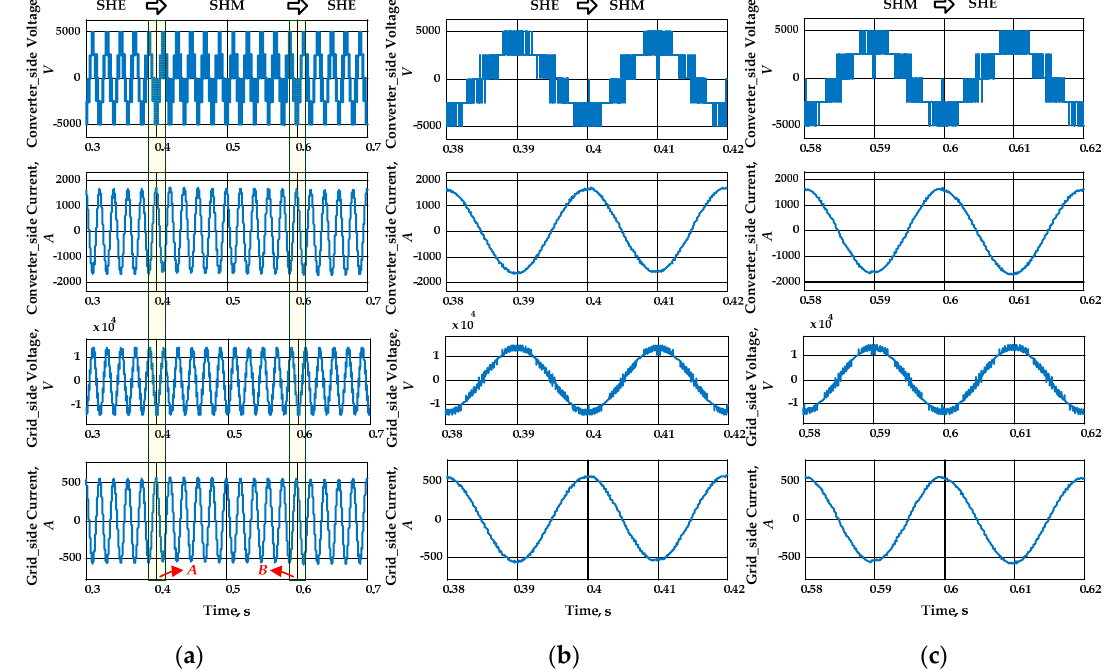
Figure 8. Simulation results of output voltage and current between SHEPWM and SHMPWM: ( a ) Transition between SHEPWM and SHMPWM; ( b ) Zoom A of output voltage and current from SHEPWM to SHMPWM; ( c ) Zoom B of output voltage and current from SHMPWM to SHEPWM.